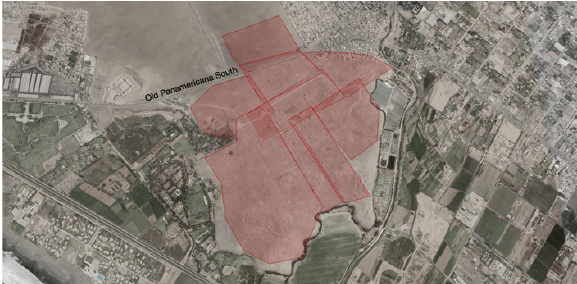
Figure 3 . Location of survey areas 100m AGL (© Google Maps